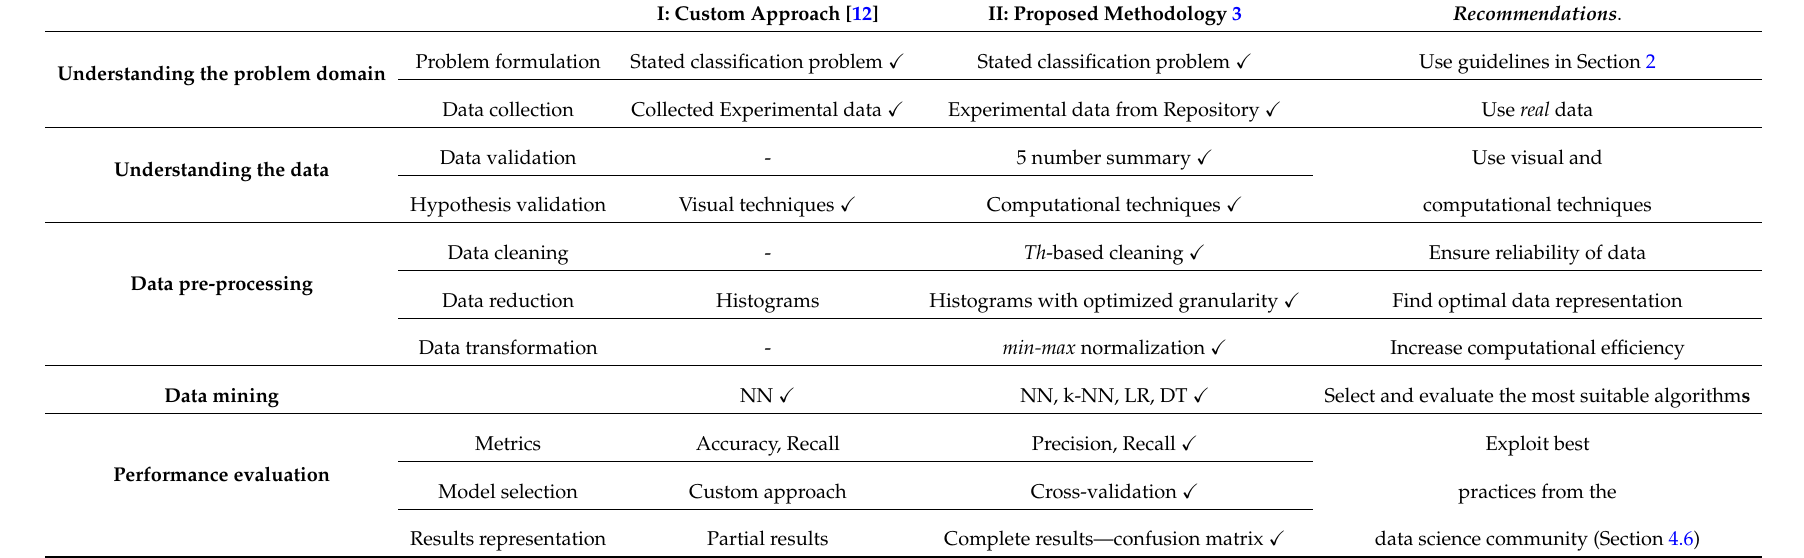
Table 13. Comparative study of the proposed methodology in Section 3 vs. the custom approach in [12]. I: Custom Approach